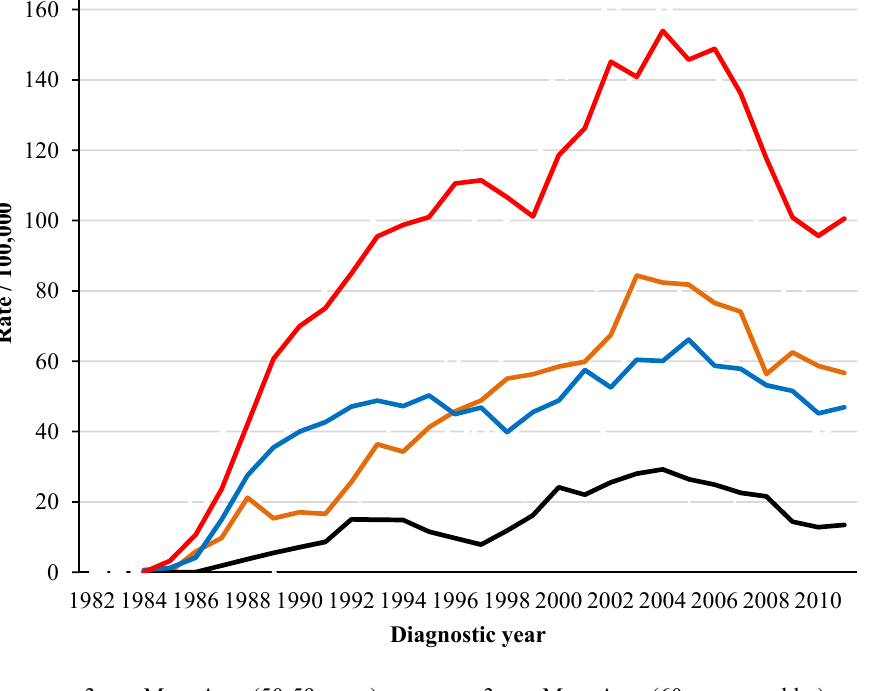
Figure 1. Trends of AIDS incidence per 100,000 inhabitants by period and age group, Niteroi/Rio de Janeiro. ( A ) male; ( B )